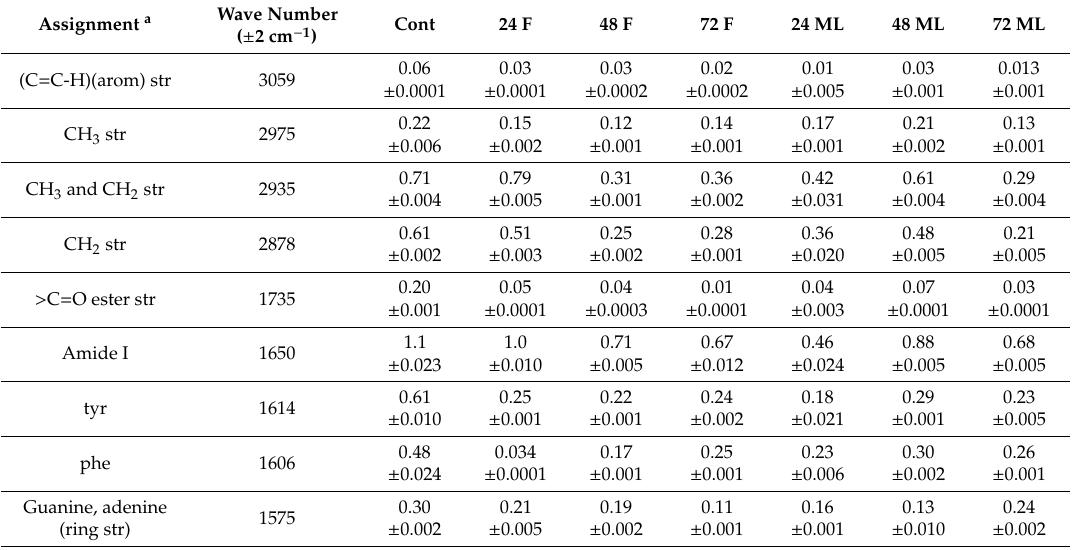
Table 2. Relative intensity values at selected regions of Raman spectra for Caco-2 cells treated with UV-radiated ML or fish oil (F). Data is expressed as mean ± SD for three baseline-corrected and normalized spectra of 128 co-added